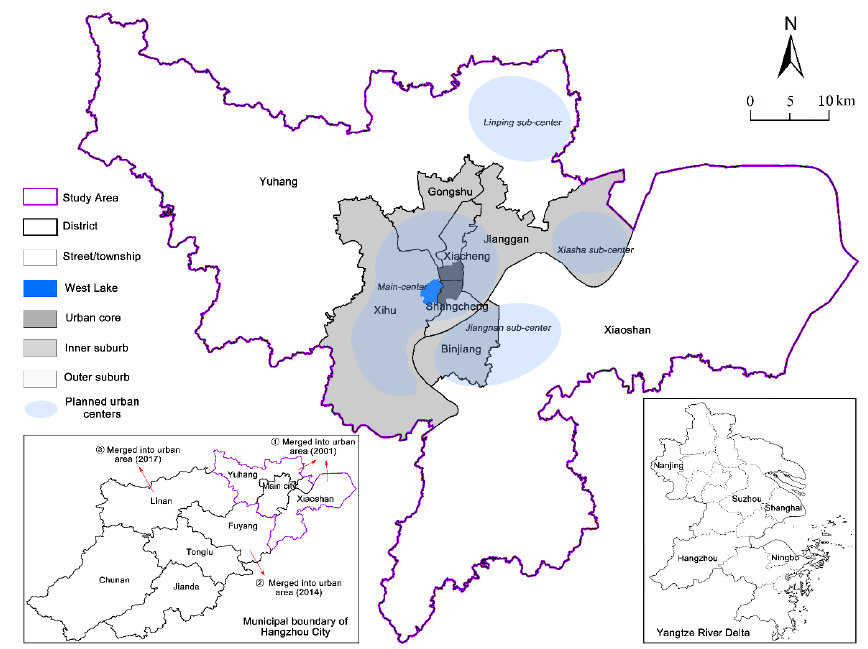
Figure 2. Map of the study area.